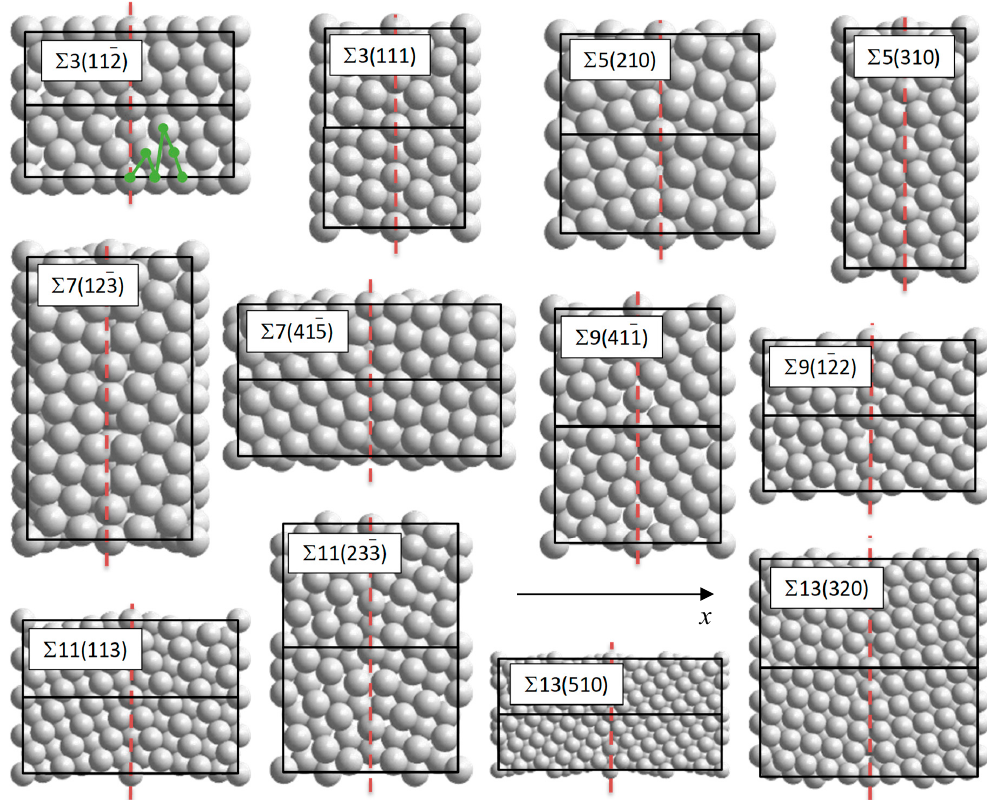
Figure 1. The different periodic grain boundary (GB) models included in this study. The dotted, red lines distinguish the GB planes. Unit cells are outlined with black lines, and the x direction is marked by the arrow. x gb is defined as the horizontal distance from the GB planes. The supercell size perpendicular to the figure plane (the z direction) is listed in Table 1. The atomic positions plotted in Figure 3 have been shown as green dots connected by a solid line for the Σ3(112(cid:3364)) model. The same pattern is found when studying the GB energy 𝛾 ; there is a clear correlation between V X and 𝛾 for the volume relaxed models, while the same is not the case when the unit cell was not relaxed. This correspondence is plotted in Figure 2a, showing that a very clear linear relation between V X and 𝛾 is obtained. The fit gives the empirical relation 𝛾 = 1.55 𝑉 (cid:3025) and 𝛾 = 1.19 𝑉 (cid:3025) for full and only x relaxation, correspondingly. The 𝑅 (cid:2870) value is 0.97 and 0.93 for the two fits. This indicates that the volume misfit is an excellent predictor for the GB energy in the case of coherent defect-free GBs, which can potentially be used in experimental studies where V X may be easier to measure than 𝛾 .